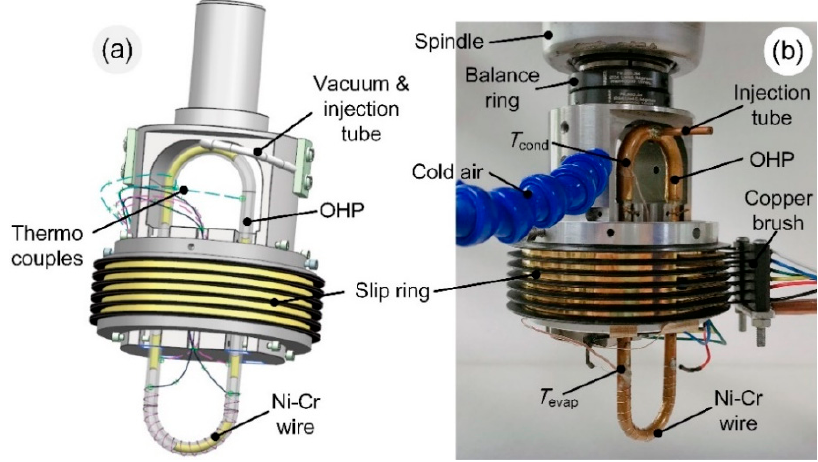
Figure 2. Experimental preparation of axial-rotating oscillating heat pipe: ( a ) illustration of axial-rotating OHP; and ( b ) experimental setup (aerogel insulation was removed for better illustration).